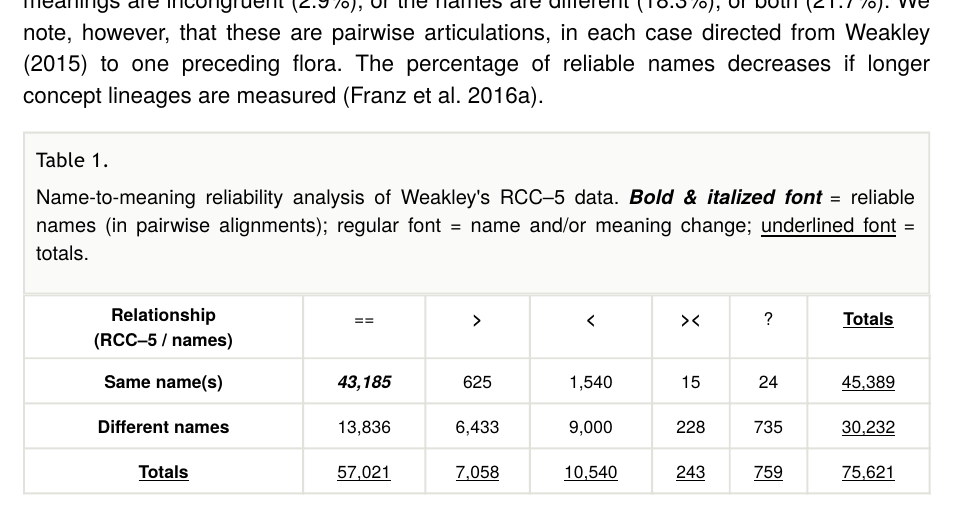
performance of taxonomic names as identi fi ers of taxonomic meanings (Table 1; Geo ff roy and Berendsohn 2003, Franz et al. 2016a, Franz et al. 2016b). The signal is good for the majority of names: 57.1% of the pairwise RCC–5 relationships involving the same name(s) are also taxonomically congruent (==). For the remaining cases (42.9%), either the